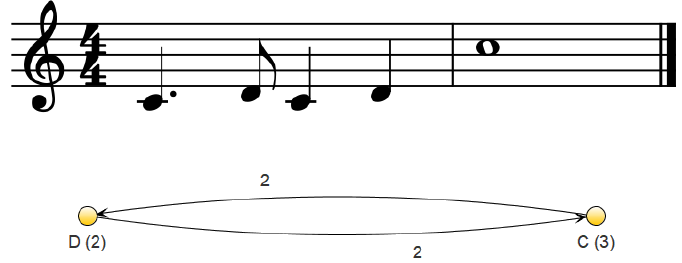
Figure 1. Sample piece and its representation. A simplified representation of notes (hence the difference in octaves and note lengths does not affect the number of vertices) and a directed network (arrows determine the direction of note precedence relationships; there are weights on vertices and directed edges) were used.